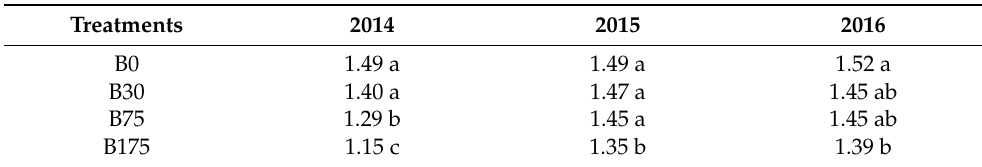
Table 1. Changes of bulk density in sulfate saline soils amended with biochar at various rates from 2014 to 2016 (g cm − 3 ).